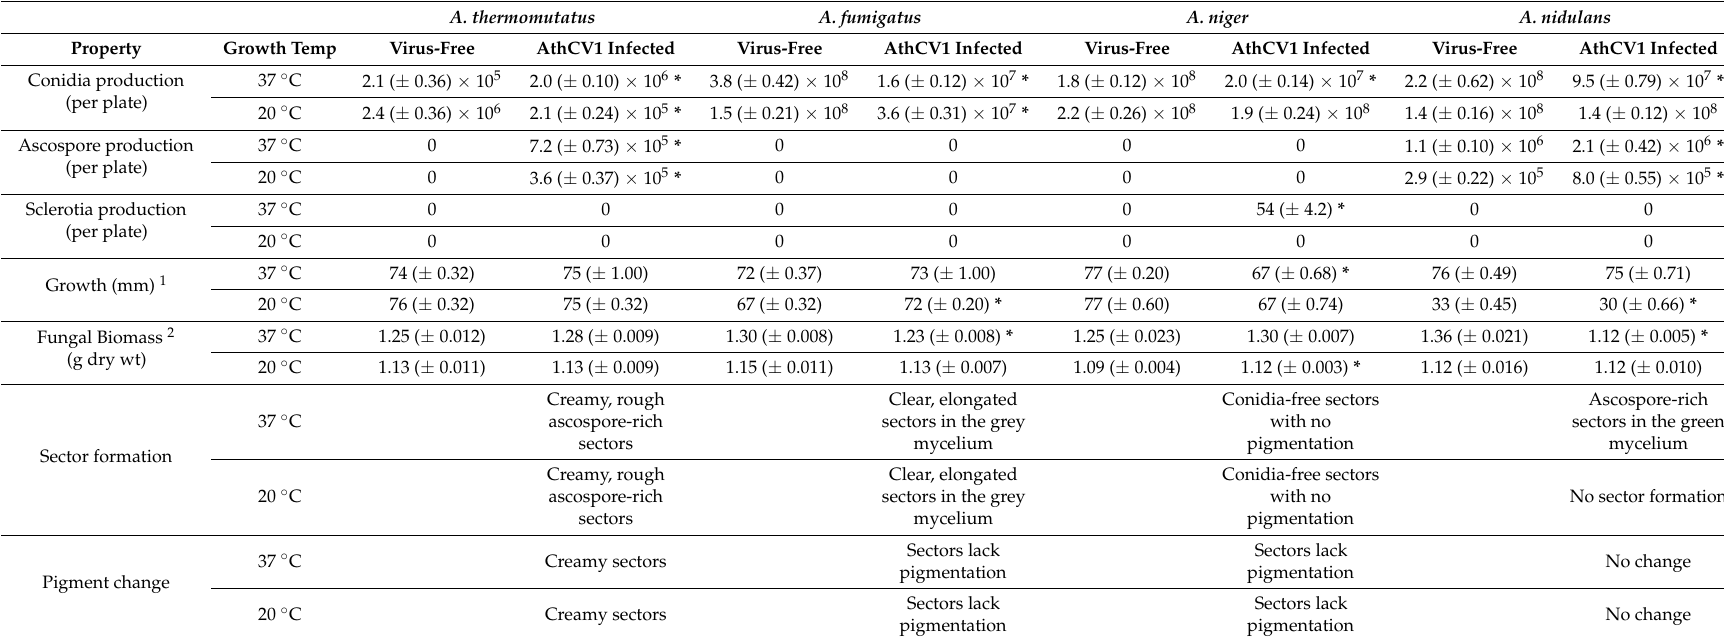
Table 1. Summary of the effects of AthCV1 on four Aspergillus